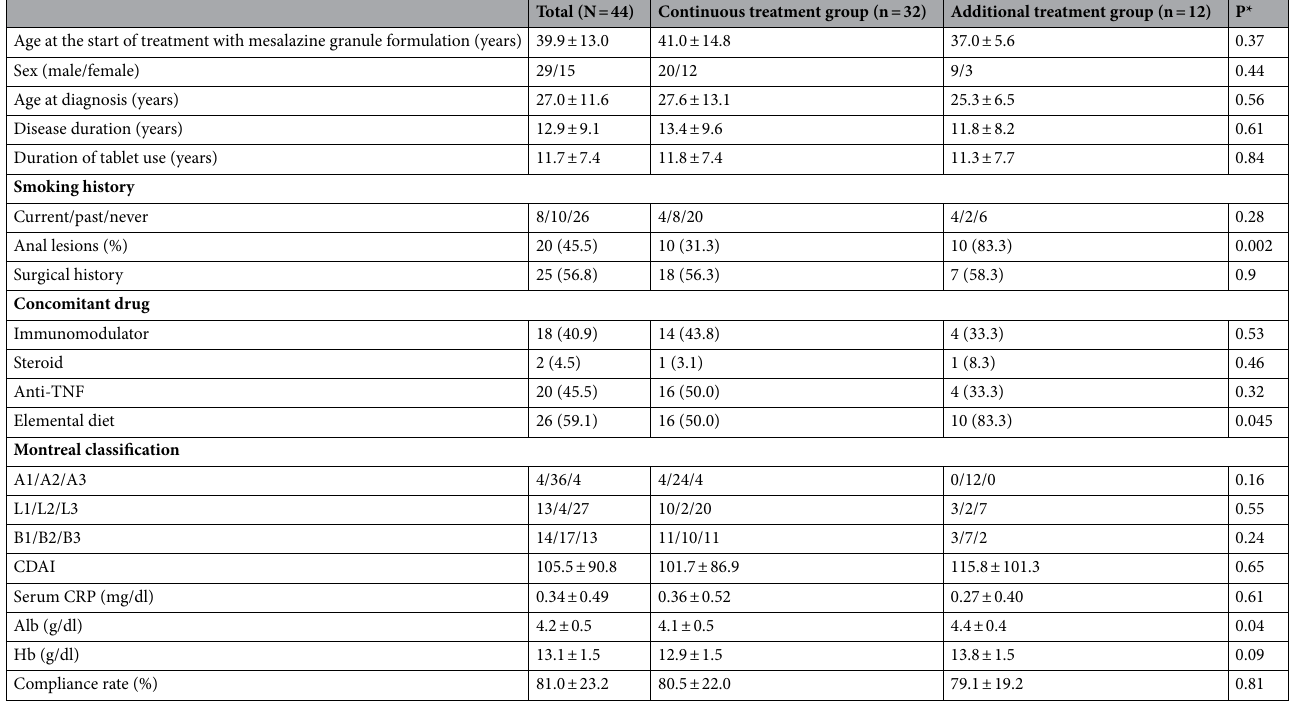
Table 1. Demographic characteristics of the 44 patients with Crohn’s disease. TNF tumor necrosis factor, CDAI Crohn’s Disease Activity Index, CRP C-reactive protein, Alb albumin, Hb hemoglobin. *Continuous treatment group vs. additional treatment